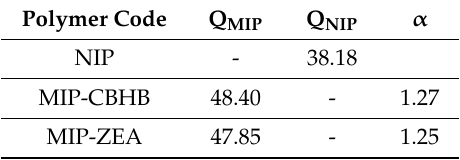
Table 10. Imprinting effect of MIPs performed by binding experiments of